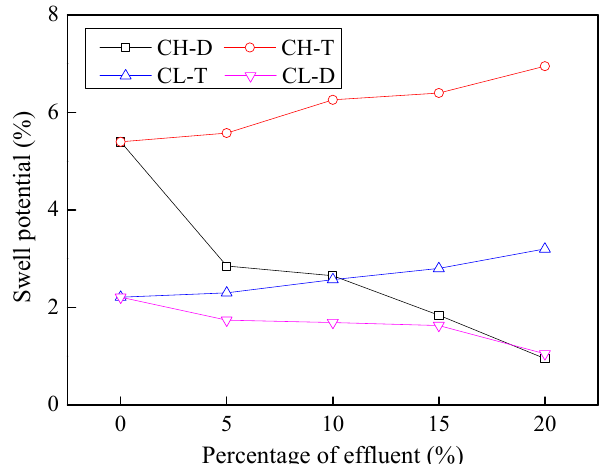
Figure 11. Effects of industrial effluents on swell potential of cohesive soils.